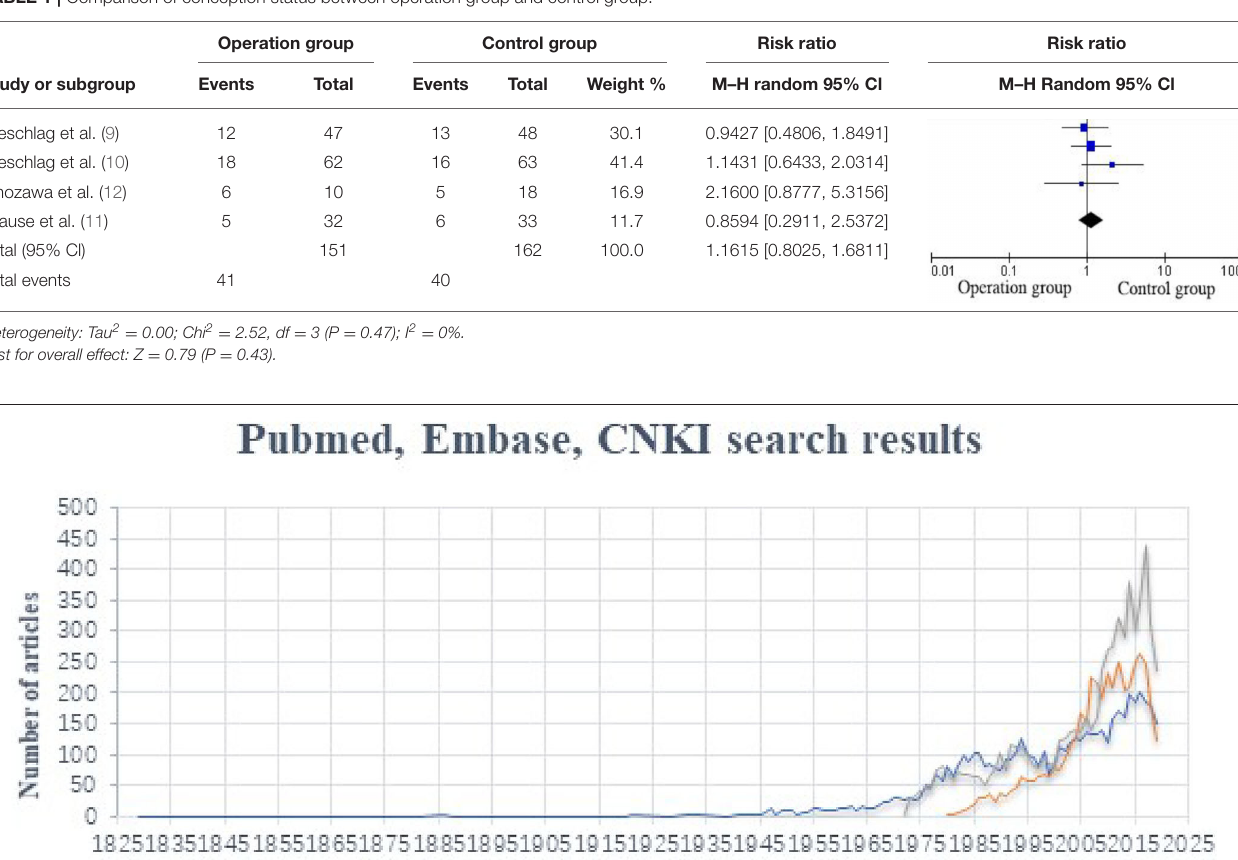
TABLE 1 | Comparison of conception status between operation group and control group.